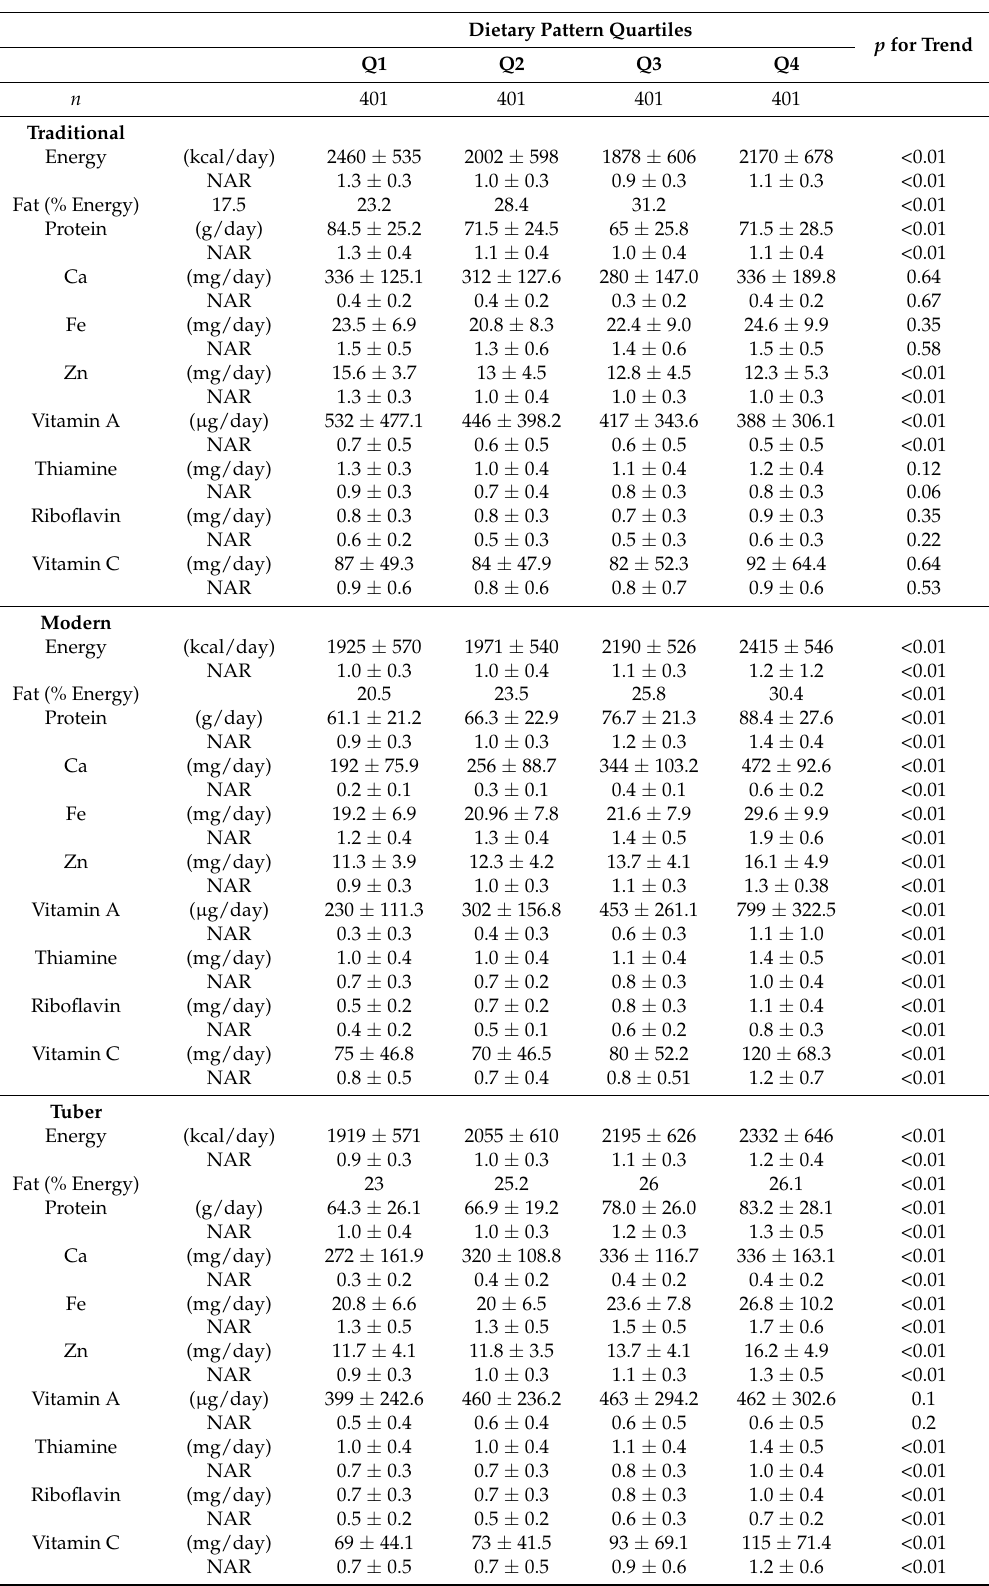
Table 4. Nutrient intakes and adequacy across quartiles of dietary patterns among adults in Southwest